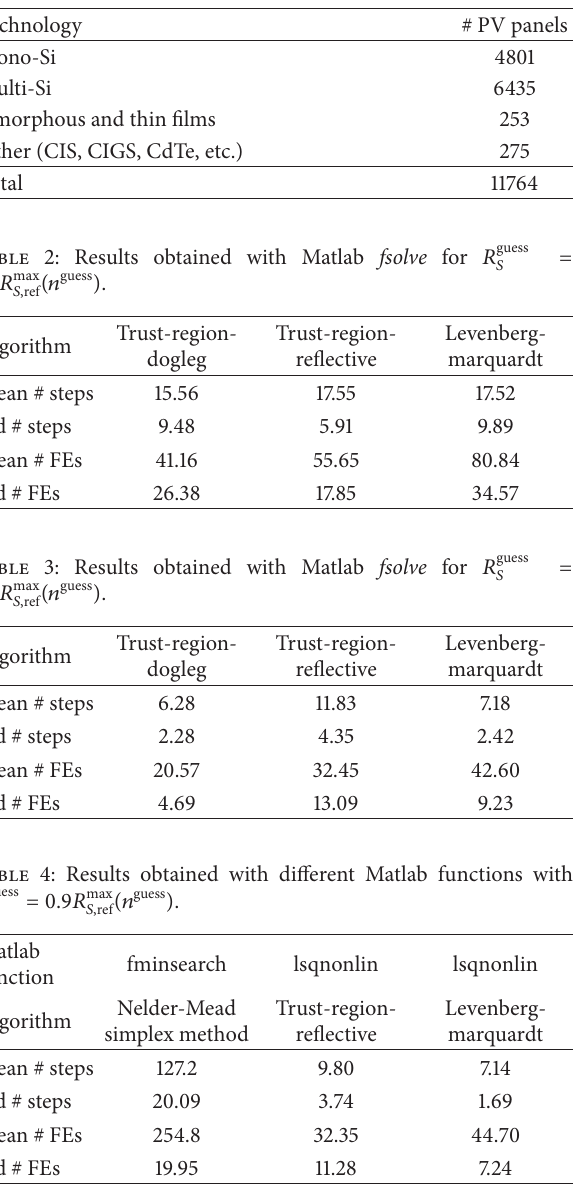
Table 1: Number of tested PV panels from CEC database grouped by type of technology.